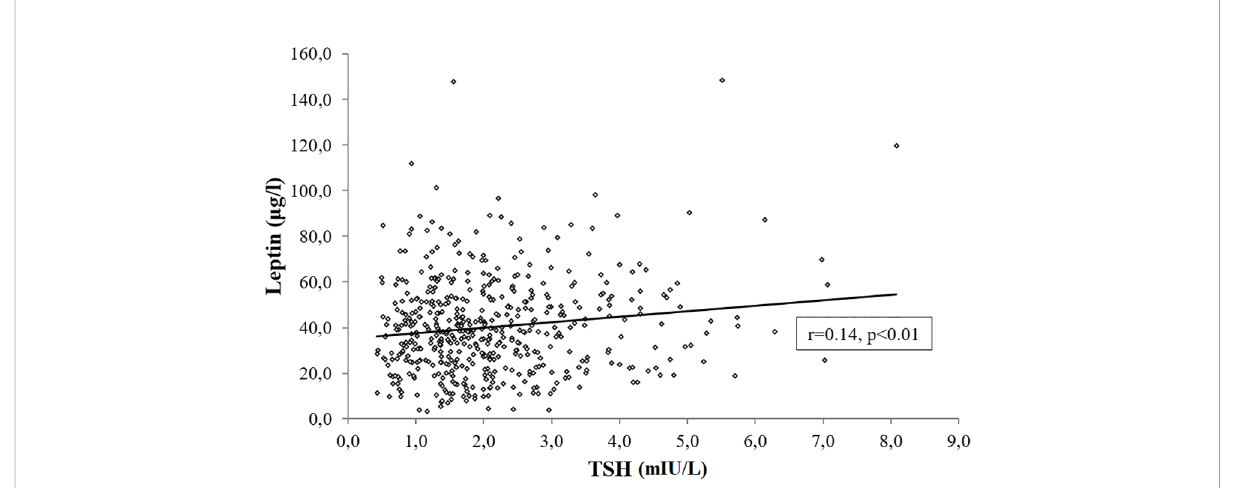
FIGURE 6 Bivariate correlation analysis between TSH and leptin levels in 502